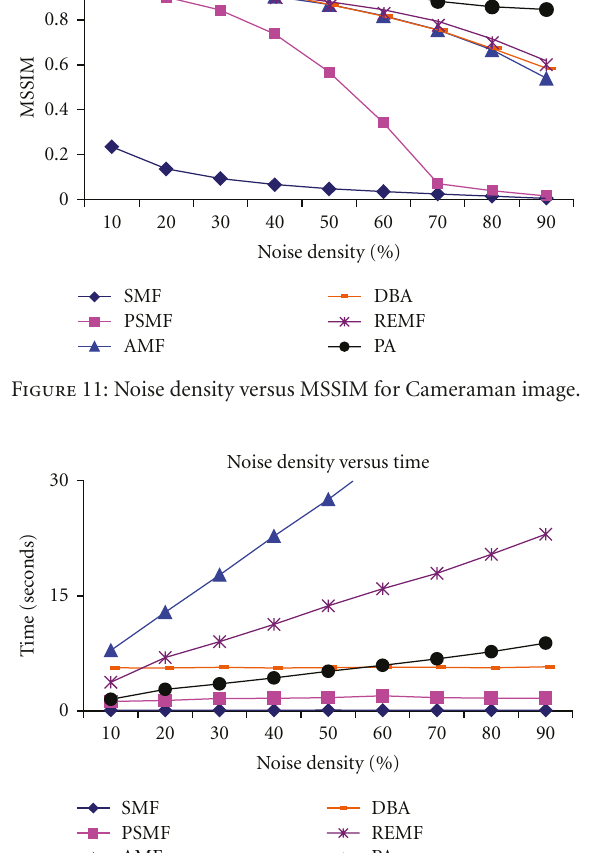
Figure 12: Noise density versus computation time in seconds for Cameraman